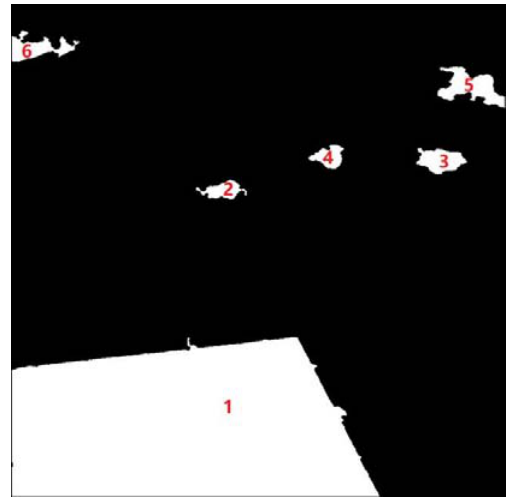
Figure 6. Obstacle map derived by combining 2D and 3D